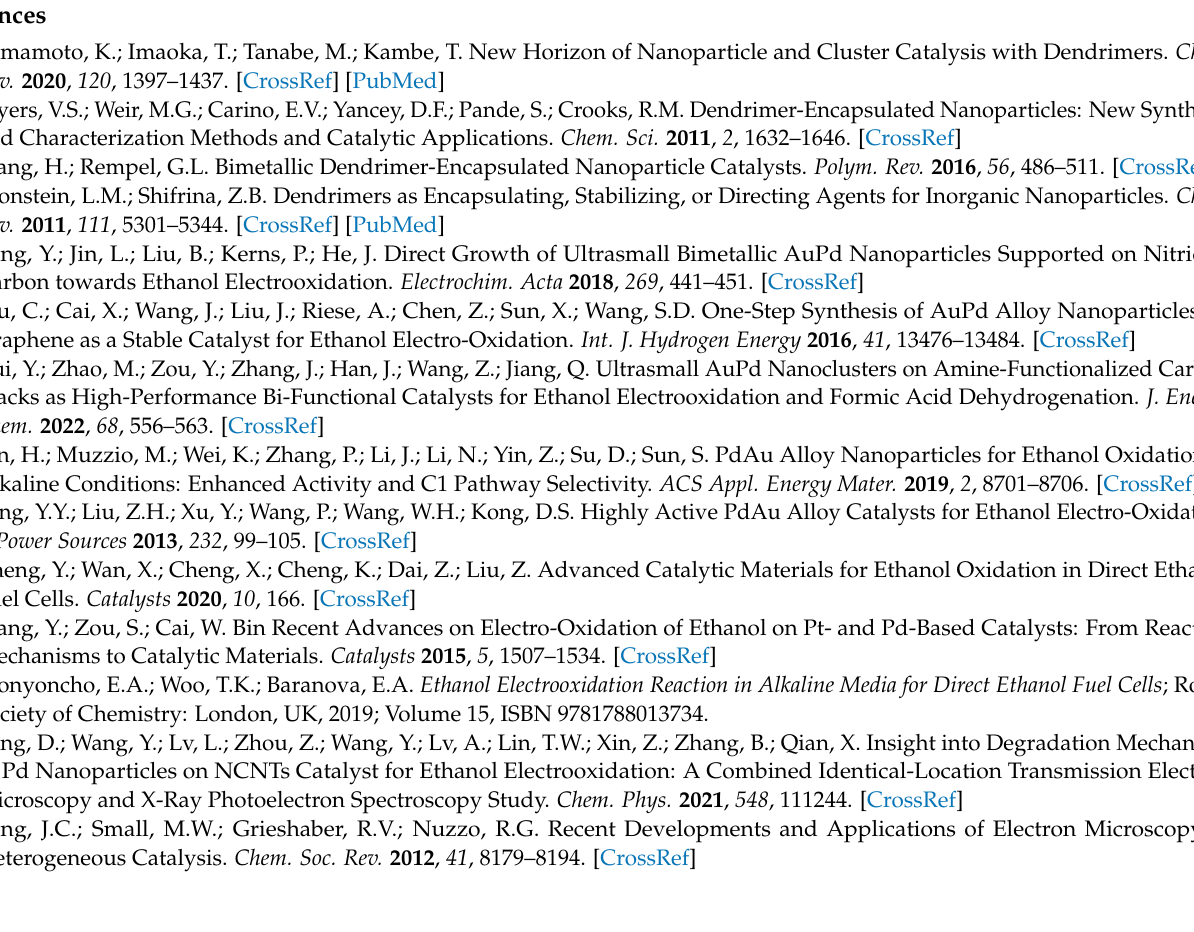
M KOH; Figure S2: ac-STEM micrographs and size-distribution histograms of DENs after EOR CVs; Figure S3: Electrocatalytic EOR CAs in stirred solution; Figure S4: Electrocatalytic EOR CVs collected before and after 1.0 h EOR CA; Figure S5: ac-STEM micrographs and size-distribution histograms of G6-OH(AuxPdy)309 DENs after 2.0 h EOR CA; Figure S6: EDS line scans and micrographs for G6-OH(AuxPdy)309 DENs after 2.0 h EOR CA; Table S1: Size distributions and Au/Pd compositions of G6-OH(AuxPdy)309 DENs after 2.0 h EOR